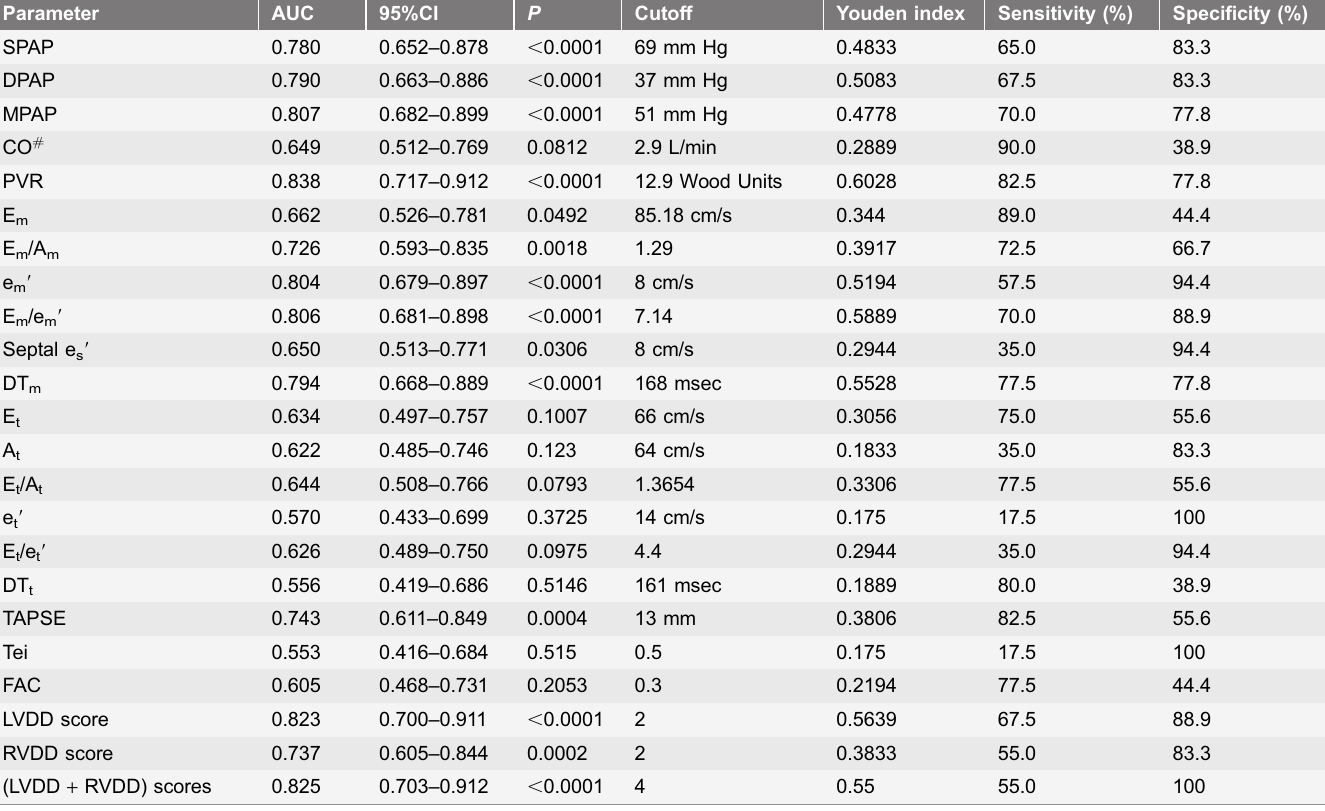
Table 5. Results of ROC curve analysis comparing different parameters of RHC, different echocardiographic parameters of left/right ventricular function, LVDD score, RVDD score and (LVDD + RVDD) scores for their accuracy in predicting unfavorable outcomes after the last follow-up.